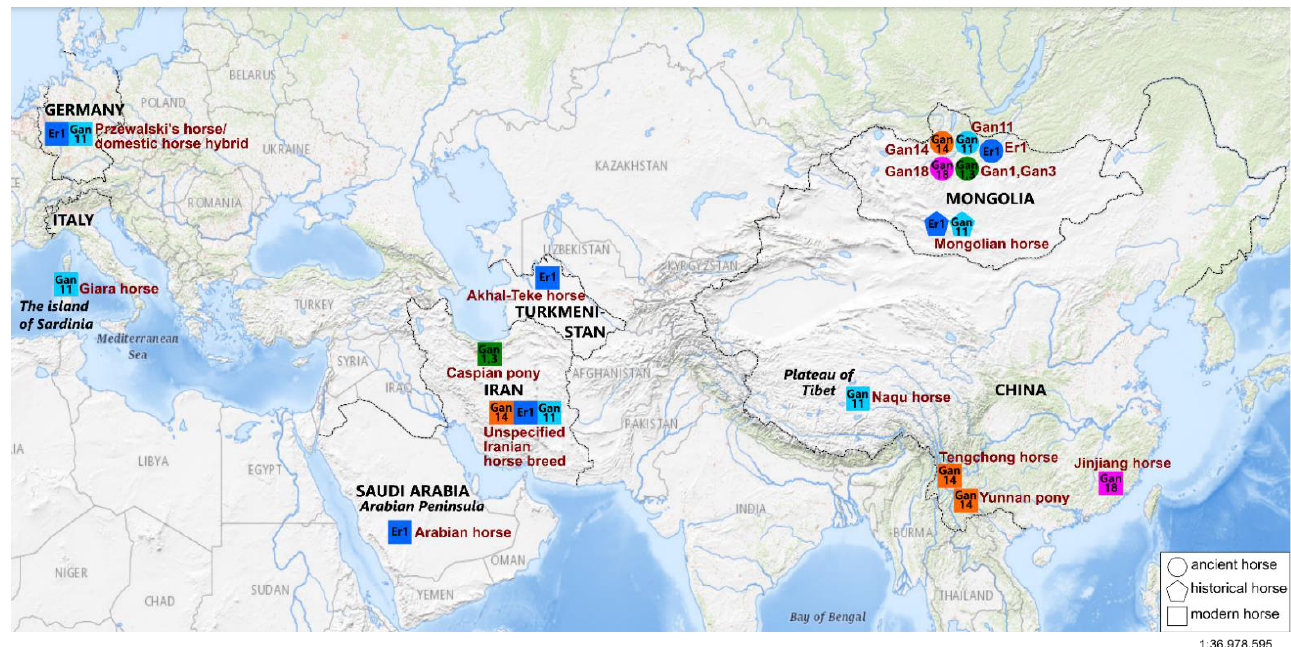
Figure 2. Geographical origin of the mitotypes closely related to the ancient ones obtained here. Circles represent ancient horses, and squares mean modern horses. Identical colors of circles and squares indicate similar mitotypes. Brown names are the names of ancient horse specimens and horse breeds. Black names and boundaries denote geographical objects within which the origin regions of closely related mitotypes are located. The figure was prepared based on the map in the USGS (United States Geological Survey) National Map Viewer (public domain) resource; it is similar but not identical to the original image and is therefore for illustrative purposes only.